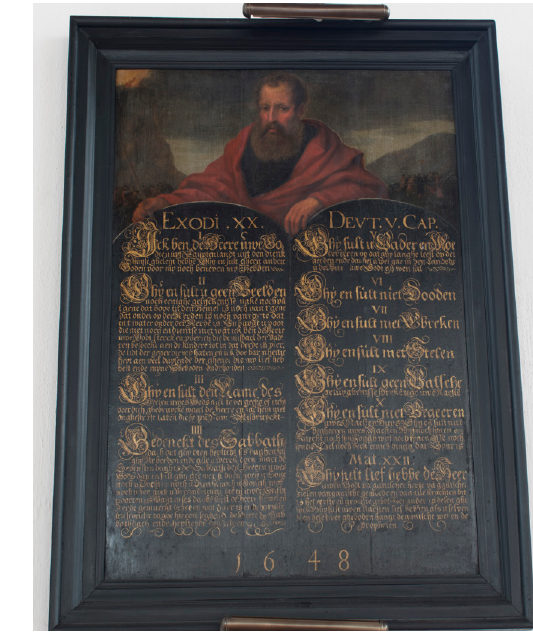
Ten Commandments panel,